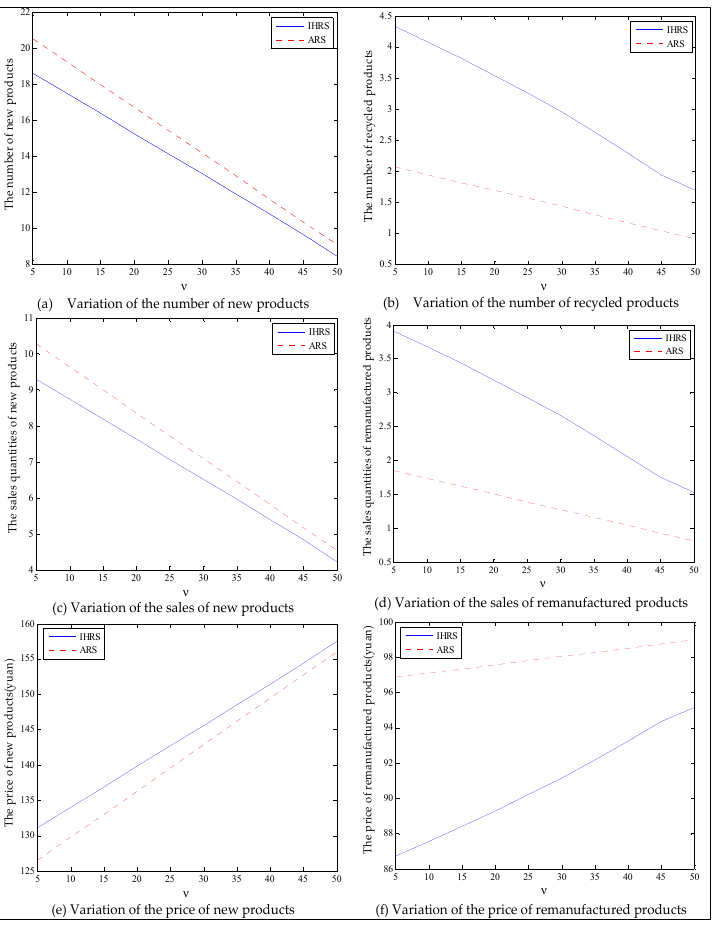
(e) Variation of the price of new products (f) Variation of the price of remanufactured products Figure 5. The variation of the equilibrium strategies in Case 1 of Section 6.1.